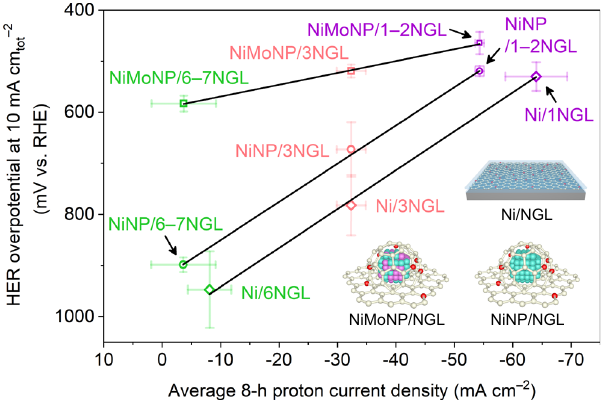
Fig. 4 Universal correlation between the HER activity and the proton penetration through the graphene layers. Graphene-covered Ni sheet, NiNP, and NiMoNP with various numbers of graphene layers were employed. Colour code: carbon (white), nitrogen (red), nickel atom (cyan), nickel sheet (grey) and molybdenum (purple). Error bars show the fl uctuations in the measured signals. The current density was normalized by the window area for the X -axis and by the total surface area of the catalysts for the Y -axis. Note: a 10 nA proton current is equivalent to a 10 mA cm − 2 proton current density.